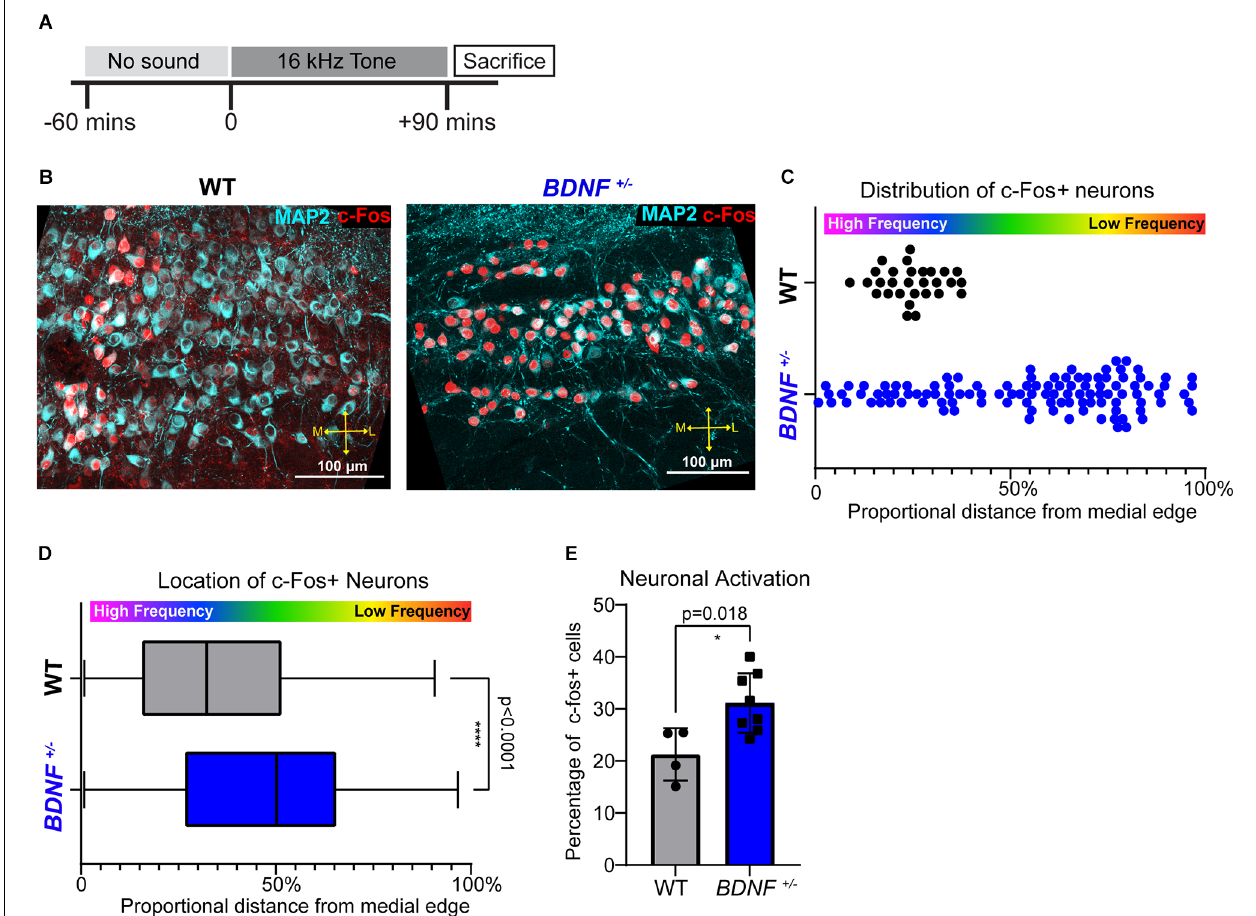
FIGURE 5 | High frequency sound responding neurons is not tonotopically organized in BDNF + / − mice. (A) Tone exposure paradigm schematic. P21 mice were exposed to a pure 16 kHz tone for 90 min preceded by 60 min of silence in a sound-attenuated chamber. (B) Representative image of the MNTB immunostained with MAP2 (cyan) and c-Fos (red). Scale bars represent 100 µ m. (C) Quantification of the representative image in (B) displayed as proportional location of each c-Fos + neuron from the medial edge of MNTB (see the MNTB border and proportional location in Figure 1B ). Each point represents one cell. Activated MNTB neurons in BDNF + / − are more laterally located (median: 24.29% in BDNF +/ and 61.12% in WT; p < 0.0001, Mann-Whitney U test). (D) Distribution analysis of c-Fos + neurons displayed as the proportional distance from the medial edge of MNTB where 0% is the medial edge of the MNTB and 100% is the most lateral edge of the MNTB. Activated MNTB neurons in BDNF + / − are more laterally located ( p < 0.0001, Mann-Whitney U test) and widespread compared to WT ( p < 0.0001, Kolmogorov-Smirnov test). **** indicates p < 0.0001. (E) Quantification of c-Fos + neurons divided by total MNTB neurons between genotypes. BDNF + / − mice ( n = 5) have larger proportion of c-Fos + MNTB neurons compared to WT ( n = 3) mice ( p = 0.018, Wel.ch’s t -test). * indicates p <